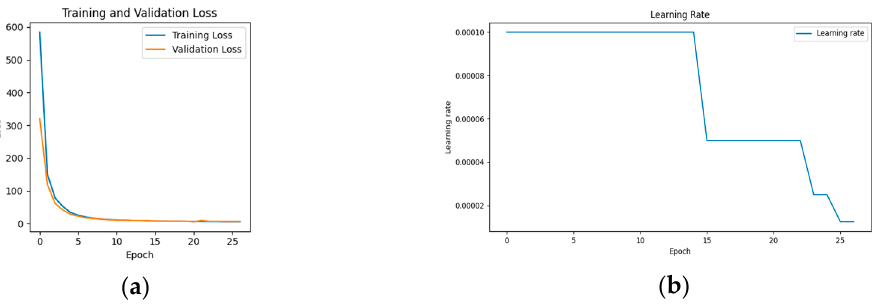
Figure 12. A description of the convergence. The training loss and learning rate of our model tend to be stable after 25 epochs. ( a ) The training error curve and the validation variation tendency; ( b ) The learning rate curve of the training phase.